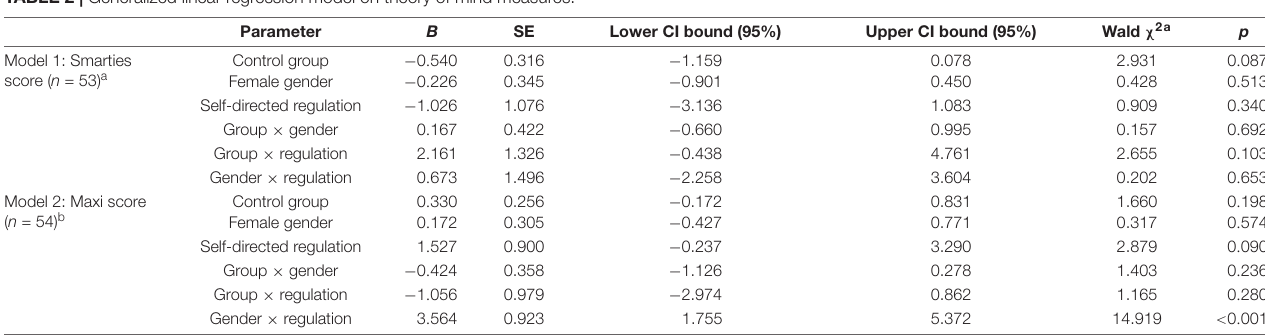
TABLE 2 | Generalized linear regression model on theory of mind